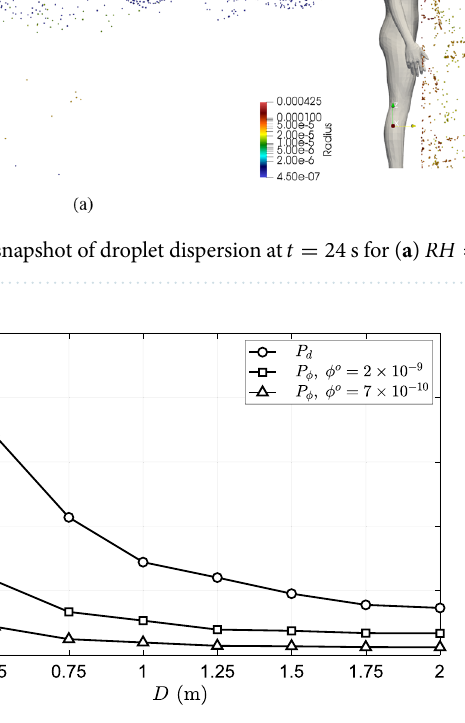
Figure 11. Comparison of probability of infection over distance based on P d and P φ for an exposure period of 15